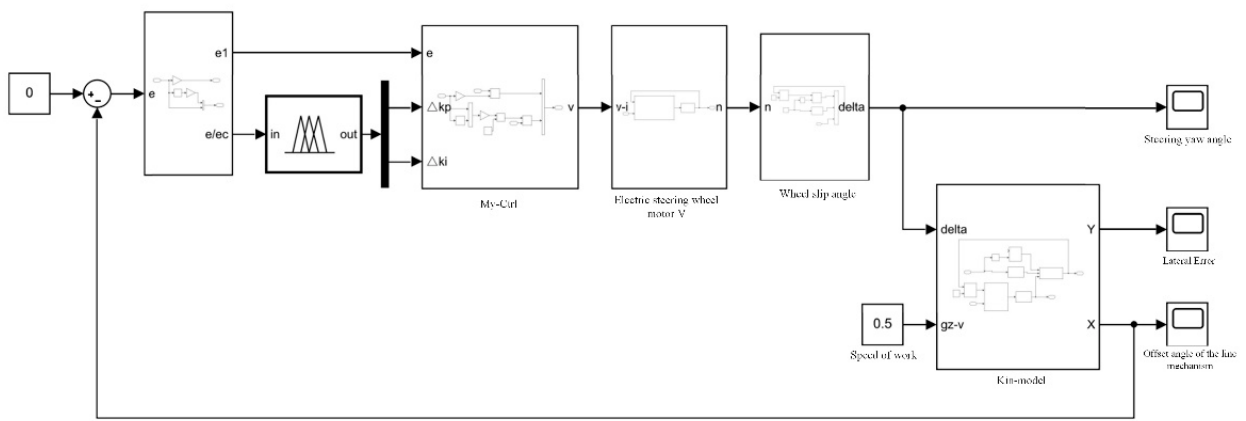
Figure 12. Simulation model of automatic alignment system.